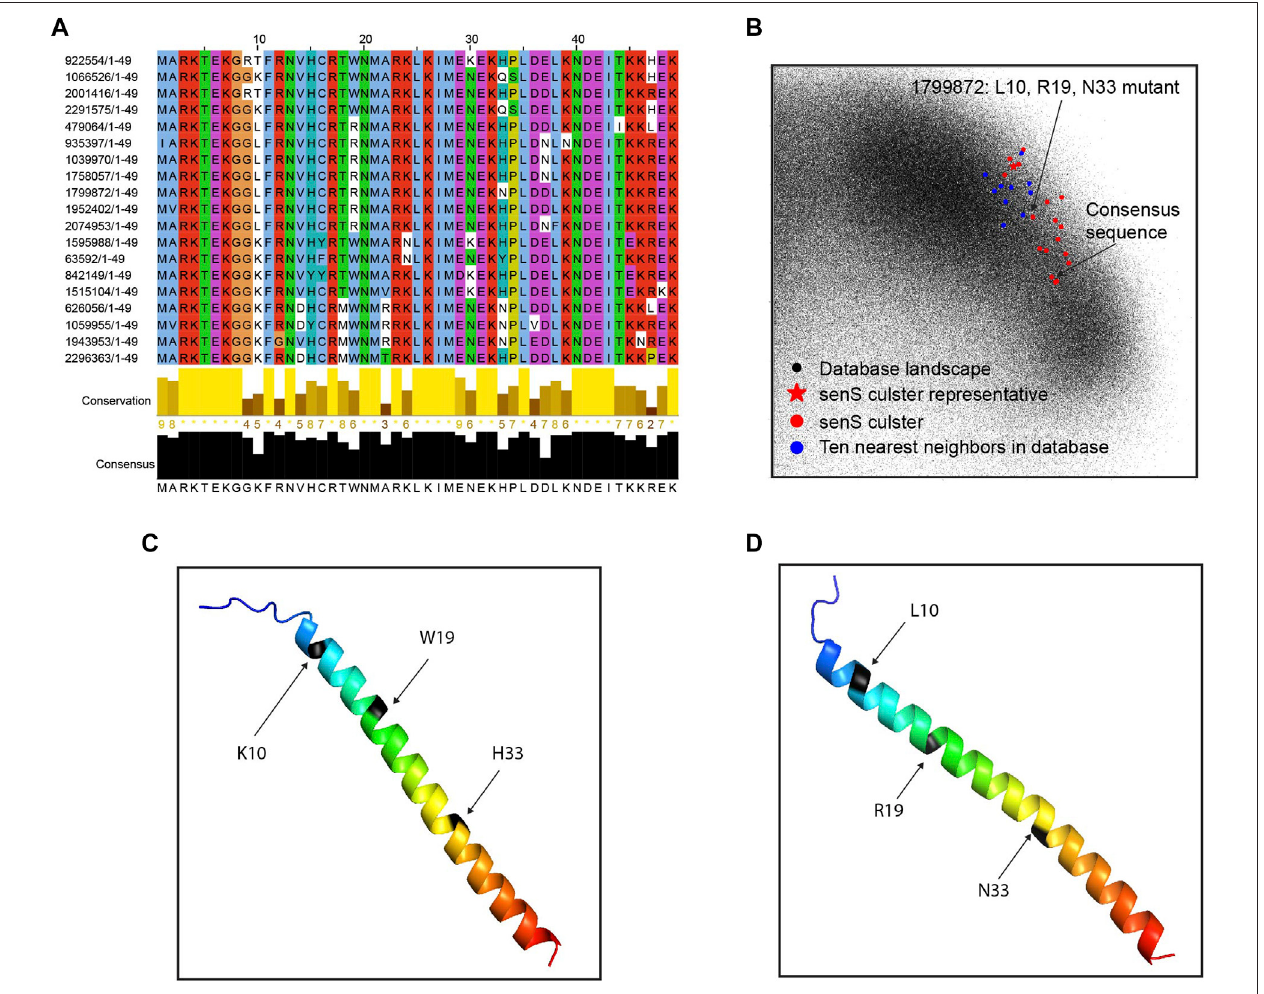
FIGURE5| SequencediversityofsenSgene. (A) Sequence alignmentand conservationofthesenSproteins. (B) The senSclusterand tenneighbors overlay onto the database landscape. (C) The predicted structure for the consensus sequence of senS. (D) The predicted structure for a mutant of the consensus.